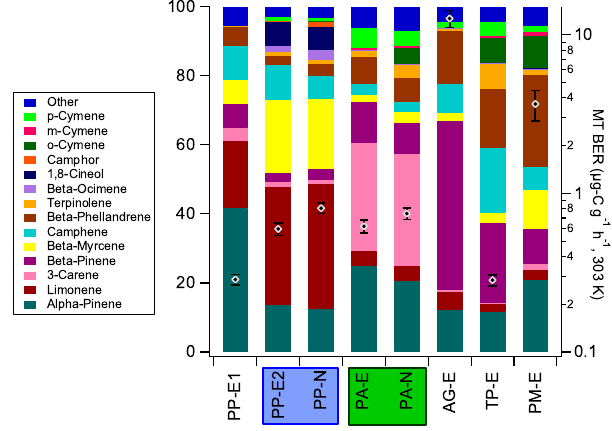
Figure 1. Pre-treatment monoterpenoid profiles for each experi- ment. PP-E1 represents Picea pungens stress experiment 1, PP-E2 is Picea pungens stress experiment 2, PP-N is Picea pungens nega- tive control, PA-E is Pinus aristata stress experiment, PA-N is Pinus aristata negative control, AG-E is Abies grandis stress experiment, and PM-E is Pseudotsuga menziesii stress experiment. The two shaded boxes denote the paired stress/negative control experiments that were performed consecutively with the same set of saplings. The left axis shows the proportion of each compound emitted as a percent of total monoterpenoids. The diamonds associated with the right axis show the average pre-treatment basal emission rate (BER) of total monoterpenes normalized to a temperature of 303K in units of µg-Cg − 1 h − 1 . The x axis label is the experiment ID (Table 1). The average BER was calculating using all data from the end of the acclimation period until immediately before the stress treatment was applied (>24h of measurements). The error bars represent the standard deviation of the averaged